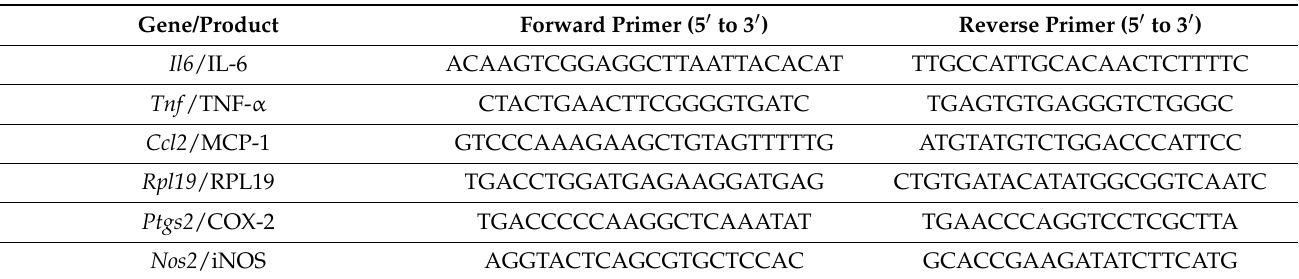
Table 4. Primer sequences for